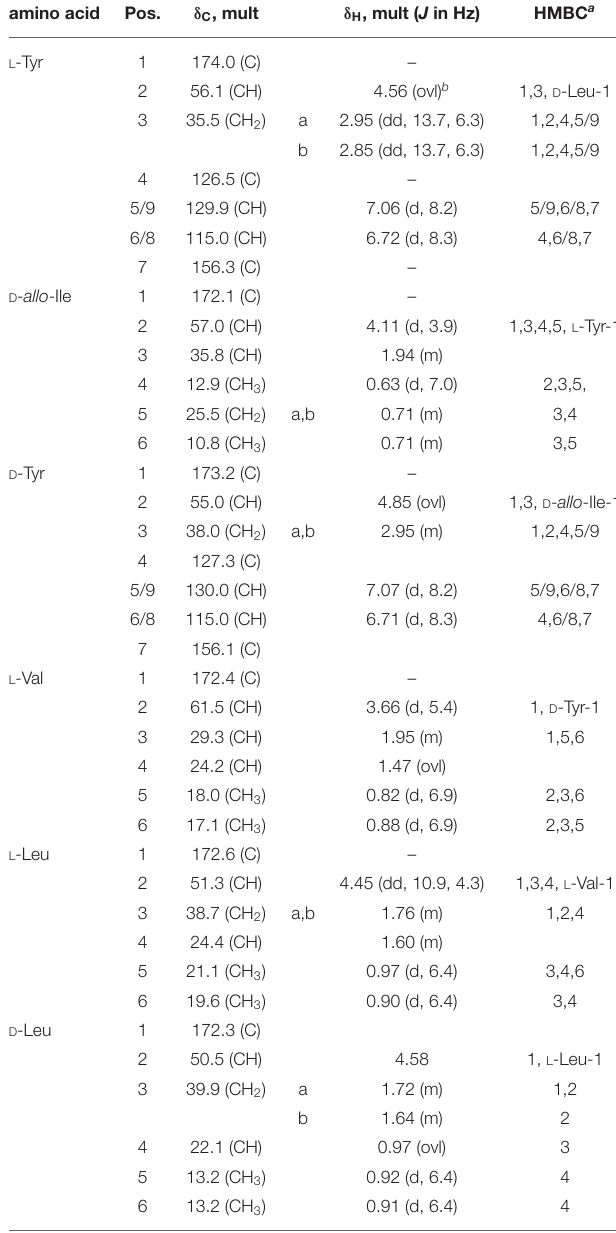
TABLE 4 | NMR data of thermoactinoamide D ( 4 ) (700 MHz, CD 3 OD). amino acid